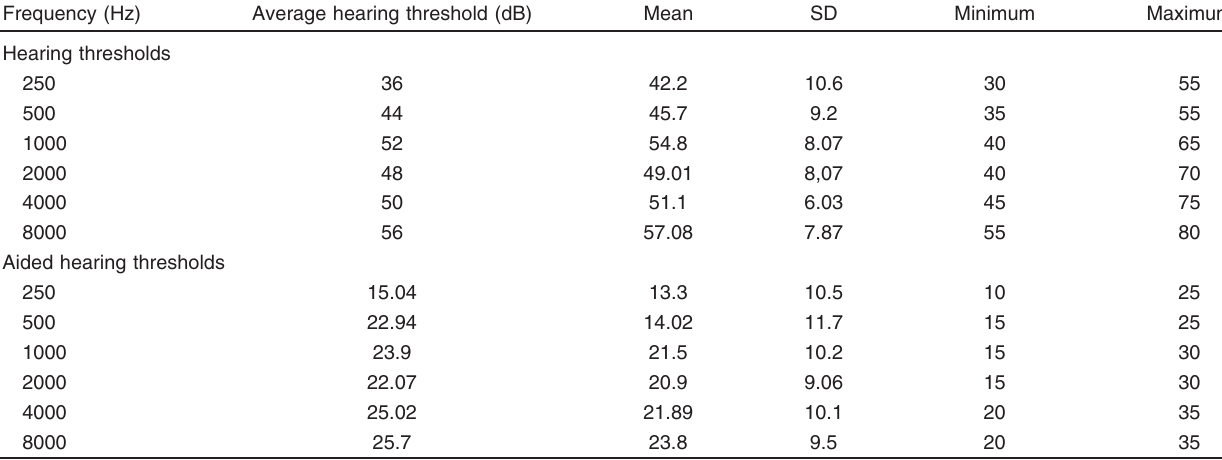
Table 1 Descriptive analysis of hearing thresholds and aided hearing thresholds of the studied group Frequency (Hz)